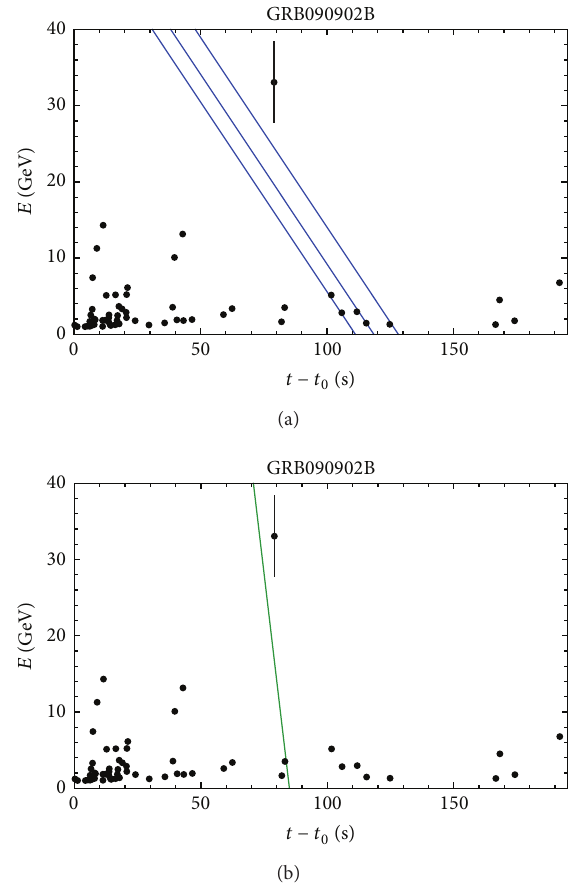
Figure 13: Here shown is the Fermi-LAT sequence of photons with energy greater than 1GeV for GRB090902B. We visualize an error bar at the 15 % level for the energy of the most energetic event. (b) A straight line with the slope we derived in Section 3. (a) Some straight lines with slope obtained from the slope derived in Section 3 by rigidly rescaling it by the factor of 𝐷(0.34)/𝐷(1.822) dictated by our (1) for a GRB at redshift of